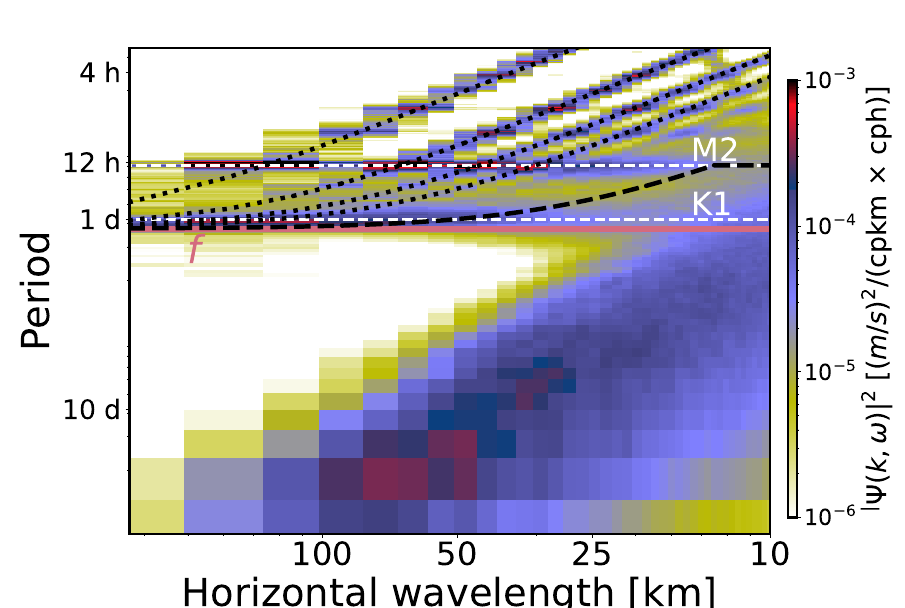
Figure 2. Power spectral density of the surface kinetic energy (KE) in the frequency–horizontal wavenumber ( ω - k h ) domain for the area centered at 26.64 ◦ N within the Canary current during the winter (January, February, March) of 2012. The black dotted lines represent dispersion relations for modes 1, 2, 3, and 10 of the internal gravity waves. The black dashed line denotes the minimum frequency between the internal gravity waves (IGW) at mode 10 and the M 2 tide, whereas the white dashed lines mark the M 2 and K 1 tide frequencies for reference purposes. The solid dark pink line corresponds to the average Coriolis frequency f in that